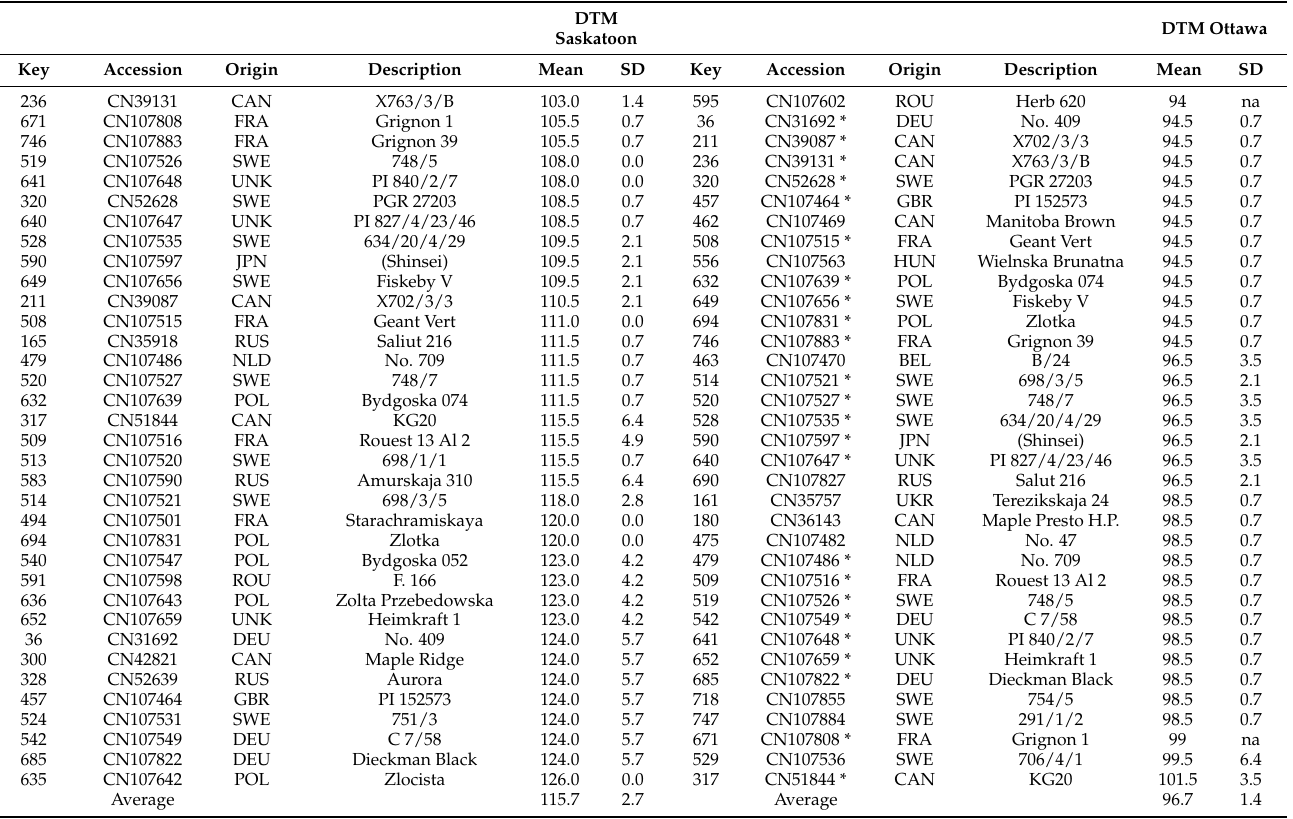
Table 1. The list of PGRC soybean accessions for maturity core subsets developed for growing in Saskatoon and Ottawa, along with their accession information and trait values (mean and standard deviation